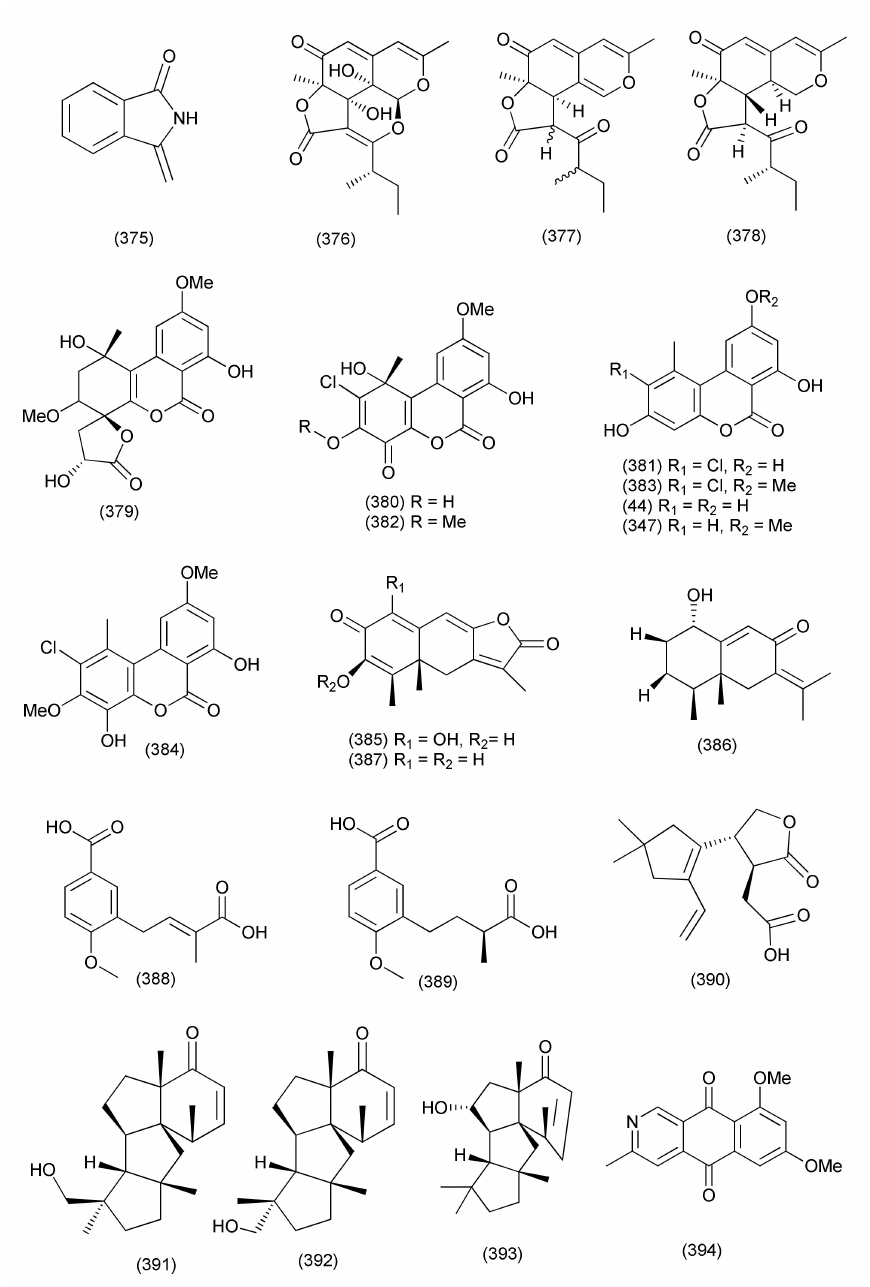
Figure 21. Structures of metabolites 375 – 378 isolated from Anamorphic Ascomycetes and 379 – 394 from Minor Anamorphic